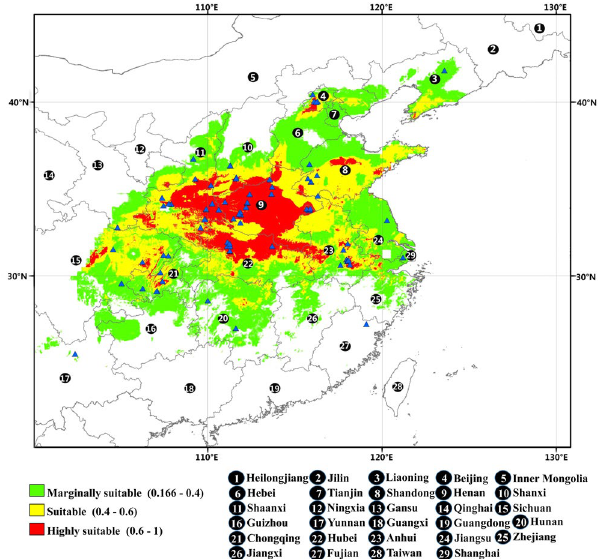
Figure 3. Kernel density plots for 11 environmental factors that affect the distribution of P . ostii .